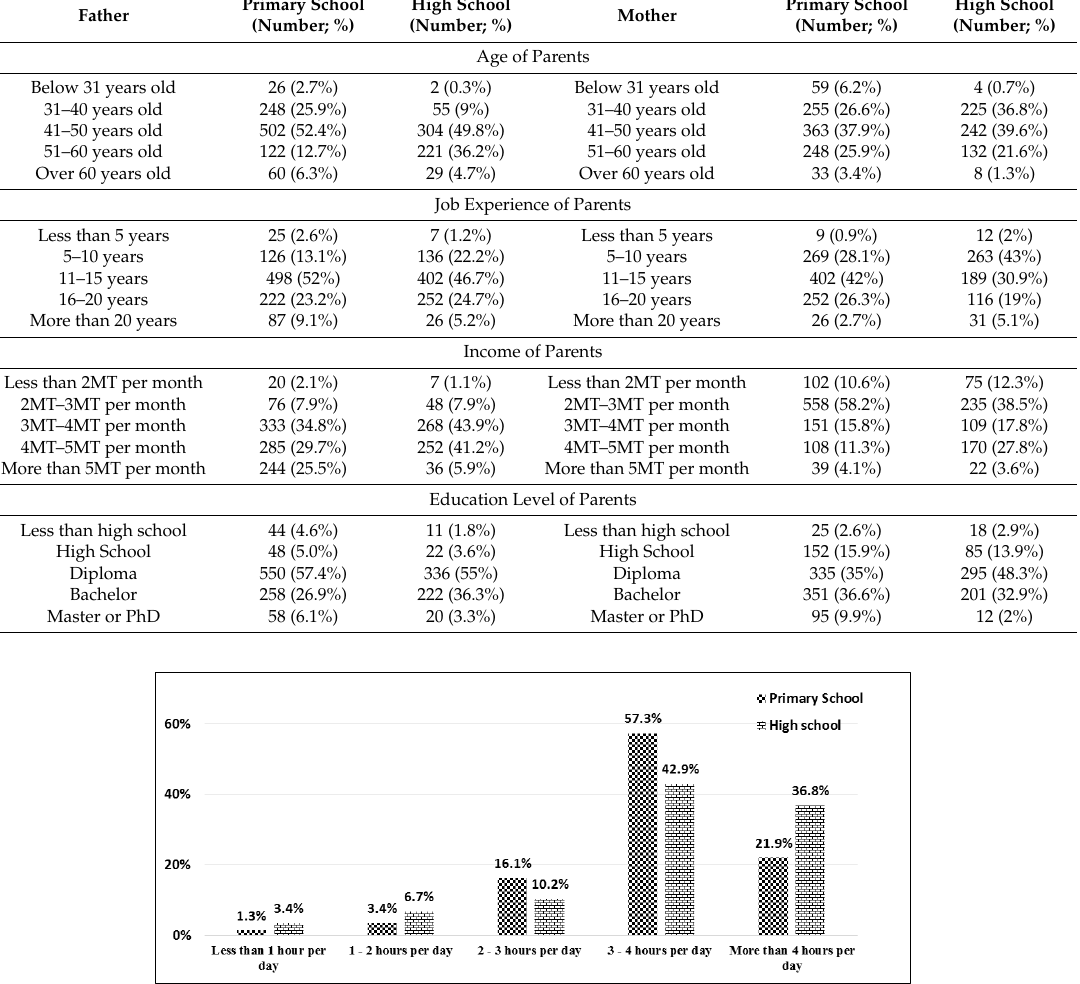
Table 3. Distributions of parents’ characteristics (primary school and high school).